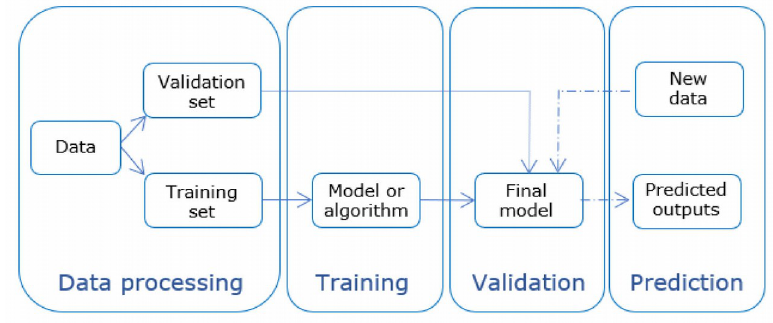
Figure 1. Implementation stages of a supervised machine learning system